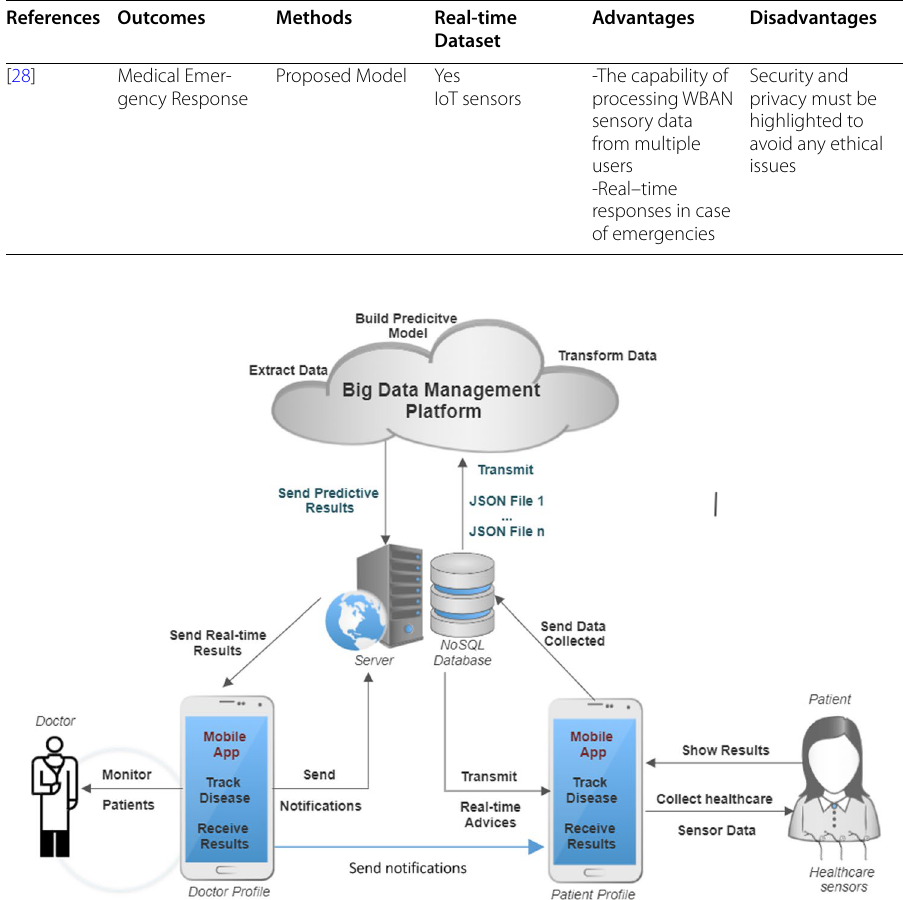
Fig. 1 E-monitoring system for real-time disease prediction